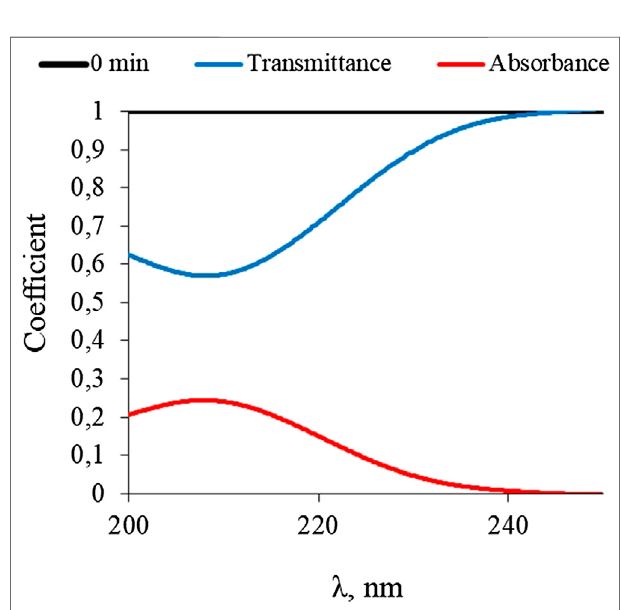
FIGURE 6 | UV transmittance and absorbance spectrum of CAP activated water. The volume of treated water 5 ml, exposure time 30 s.